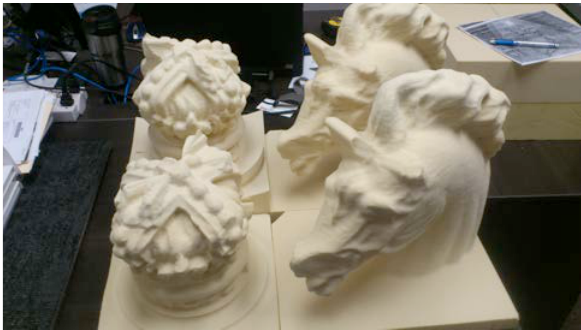
Figure 8. Polyurethane foam models